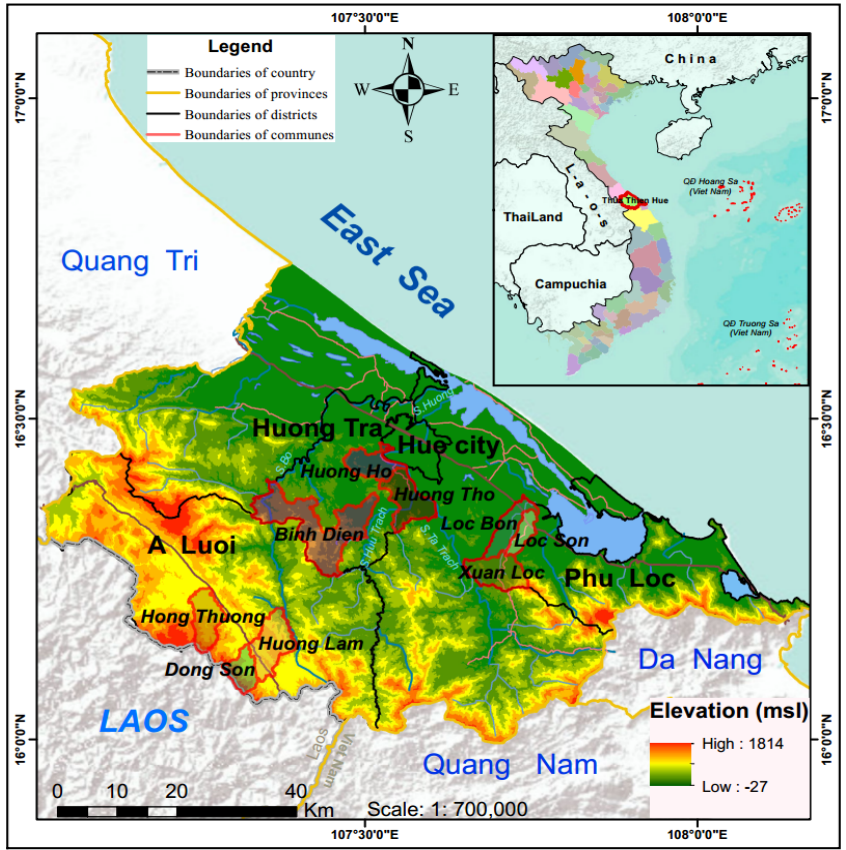
Figure 1. Map showing the location of the nine surveyed communes within three districts in Th ừ a Thiên Hu ế Province, Central Vietnam. Map by B.T.V.